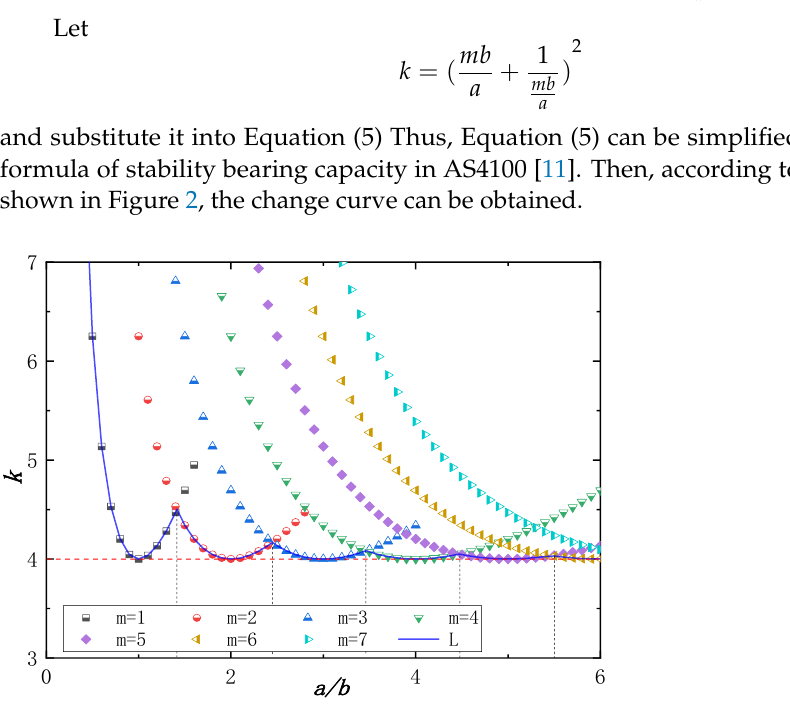
Figure 2. The variation of the buckling coefficient of the side plate with different height-width ratios and half-wave numbers in the direction of x (unidirectional stress).